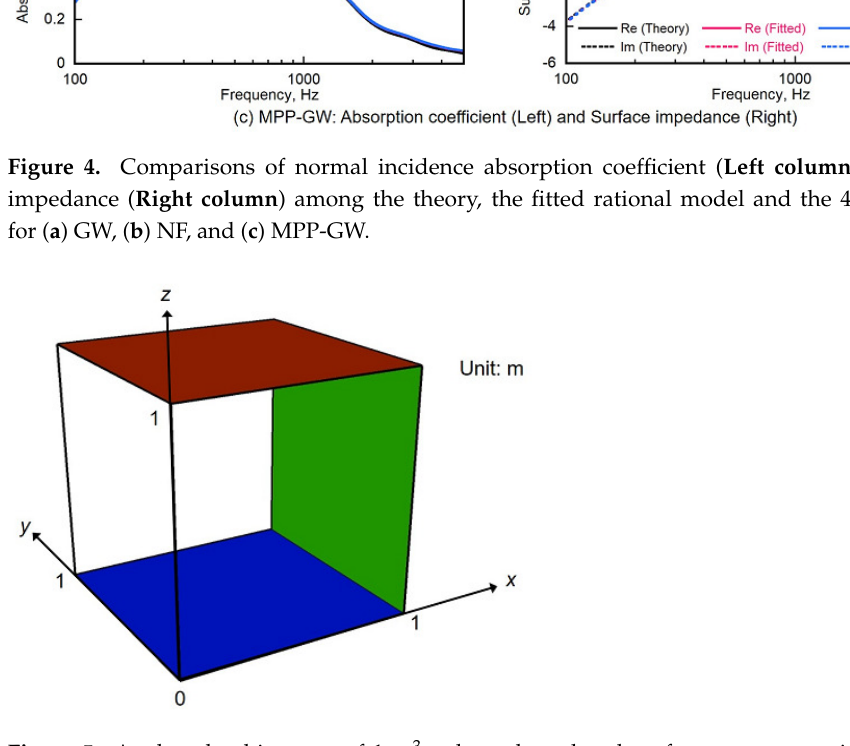
Figure 5. Analyzed cubic room of 1 m 3 , where the colored surfaces are, respectively, assigned frequency-dependent impedance of GW (red), NF (blue), and MPP-GW